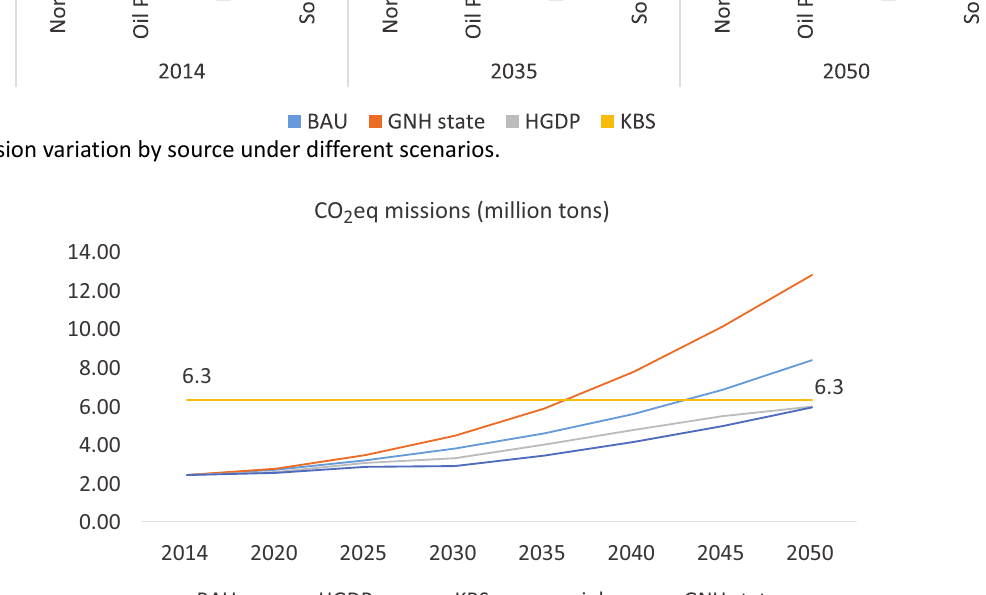
eq emission in Million 2